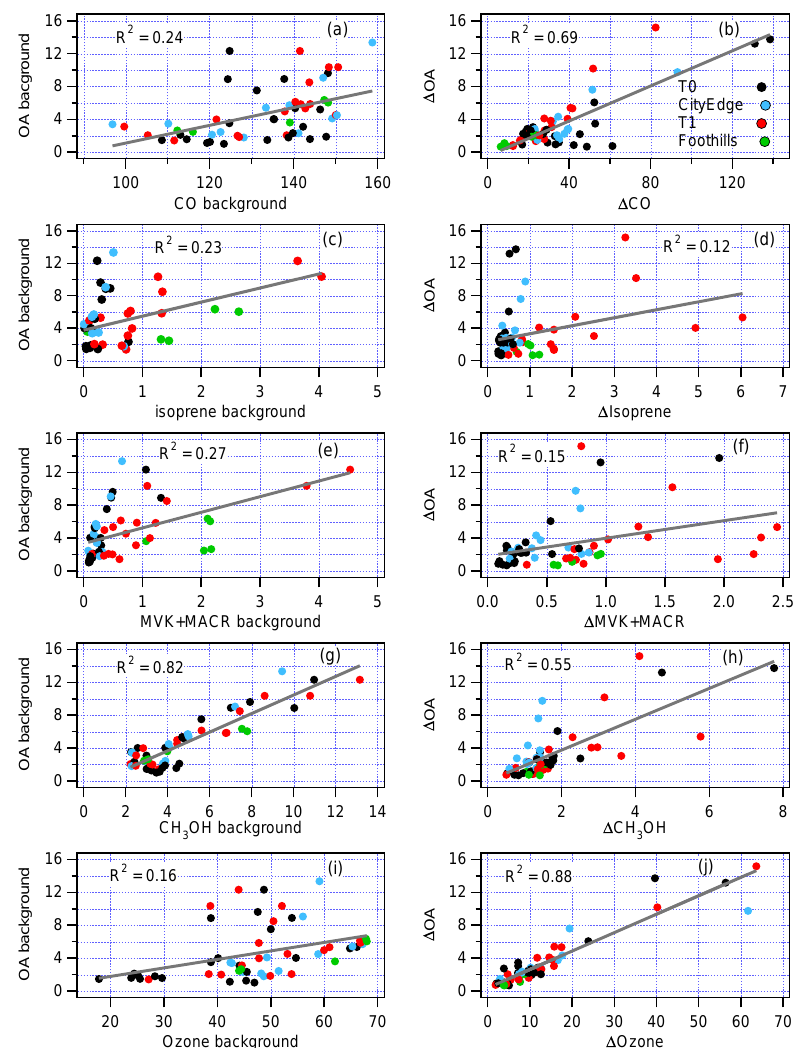
Figure 7. OA as a function of CO, isoprene, MVK + MACR, CH 3 OH, and O 3 for 56 transects. Background concentrations in panels on left-hand side; (cid:49) Concentrations on the right-hand side. Color legend in panel (b) identifies data according to location. Gray lines are linear least-squares fits with R 2 given in each